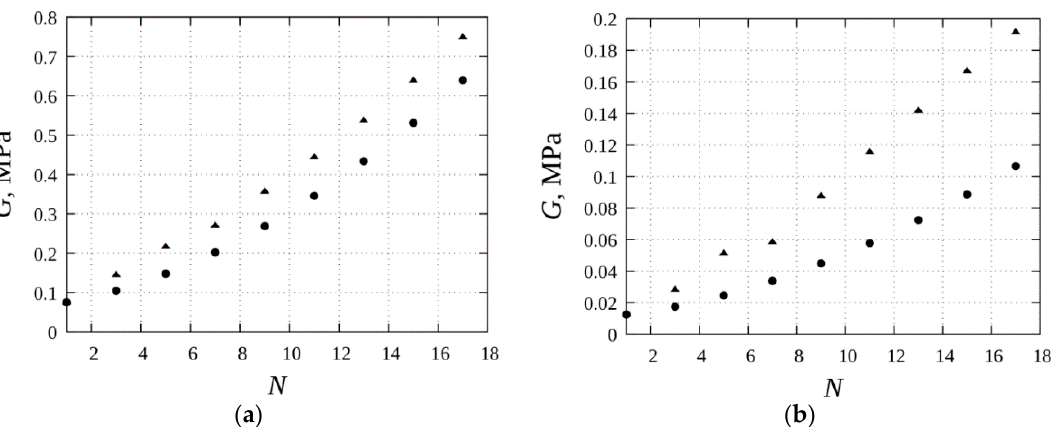
Figure 4. Shear modulus G vs. the total number of particles N. Squares—magnetic field is zero; triangles—magnetic flux B = 0.7 T. Parameters of the system: the initial magnetic susceptibility of the material of the particle material χ p = 100; the saturated magnetization of the particle material M s = 1670 kA/m; the volume concentration of the particles φ = 0.10. Shear modulus of the elastic matrix G 0 = 60 kPa ( a ) and 10 kPa ( b ).